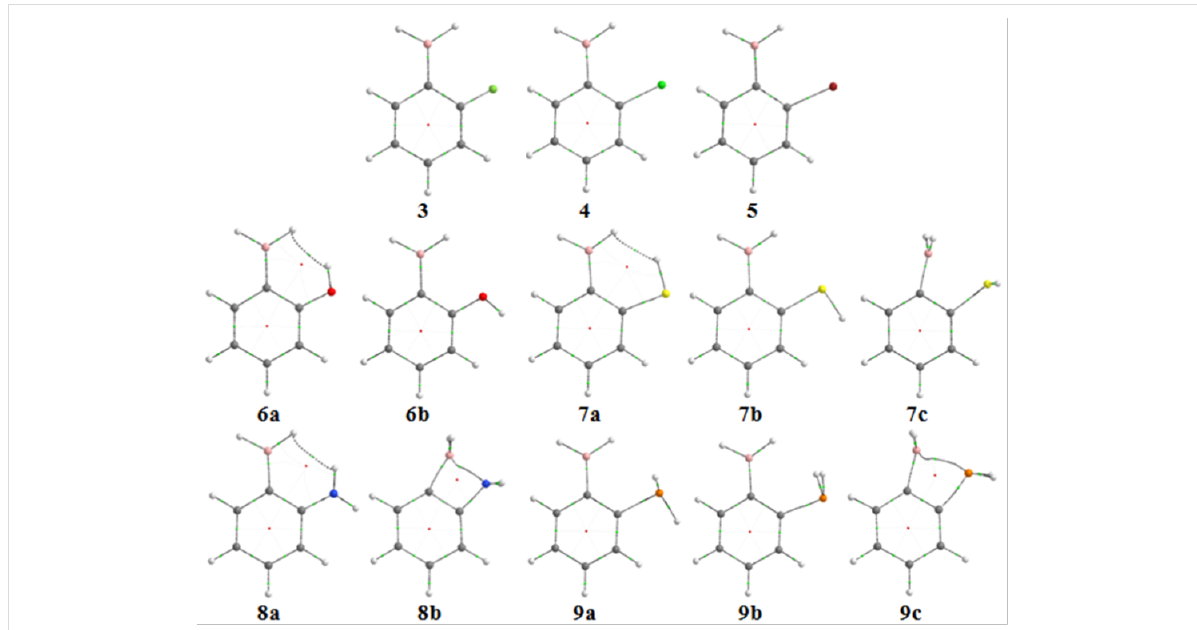
Figure 7: Molecular graphs indicating bond paths (BPs), bond critical points (BCPs; green dots), and ring critical points (RCPs; red dots) for the conformers of 2-substituted phenylboranes 3–9 .